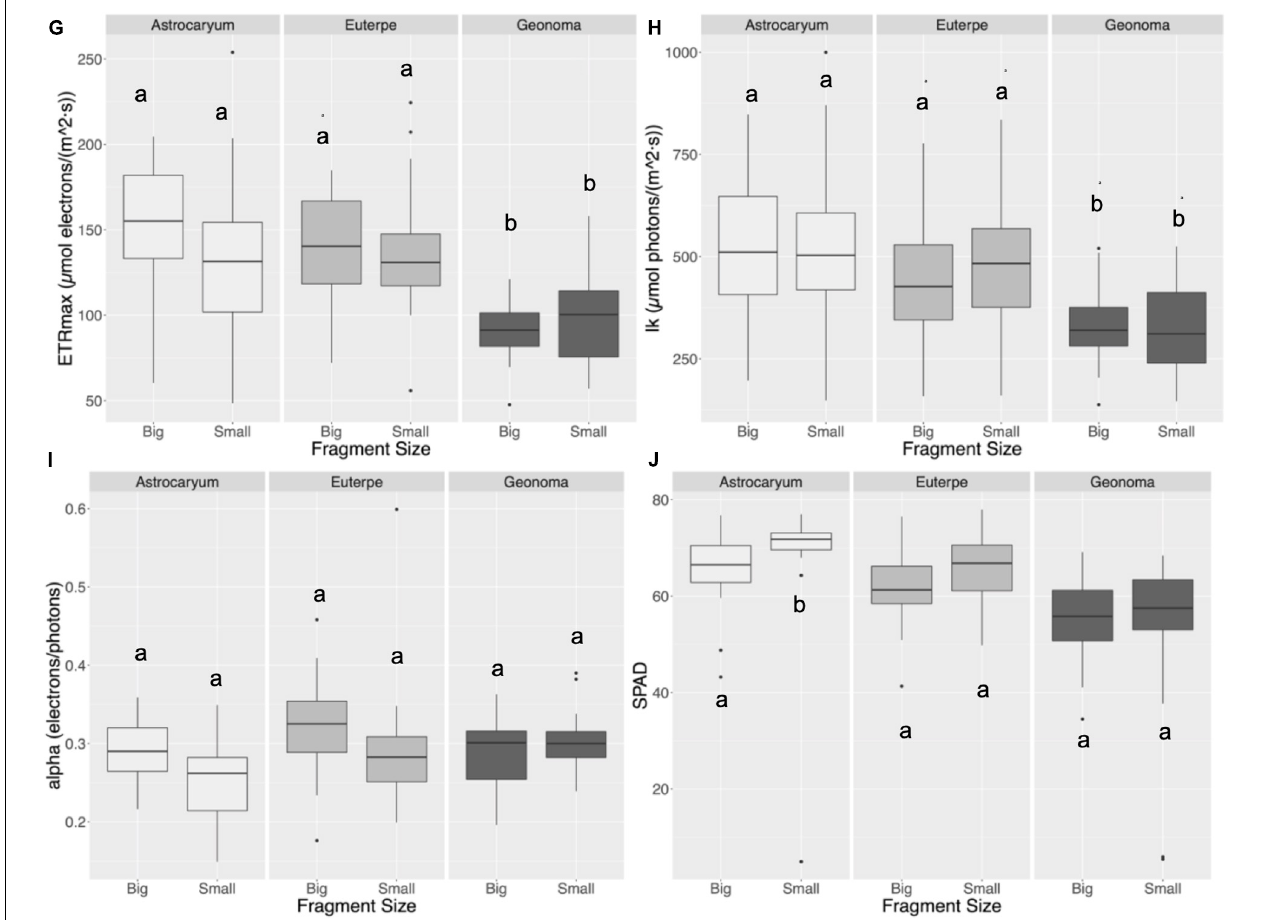
FIGURE 2 | Functional traits measured for each palm species in large and small fragments: height (H, cm – A ), basal stem diameter (BSD, mm – B ), leaf area (LA, cm 2 – C ), leaf thickness (TH, mm – D ), and leaf dry matter content (LDMC, mg · g − 1 – E ), specific leaf area (SLA, m 2 · kg − 1 – F ). We used rapid light curves (RLC) to measure the present state of photosynthesis using a PAM-2500 Portable Chlorophyll Fluorometer (Waltz). RLC provide the key parameter α (alpha, electrons/photons – I ), which represents the initial slope of RLC related to the quantum efficiency of photosynthesis, maximum electron transport rate [ETRmax, µ mol electrons/(m 2 · s) – G ], and I K , [ µ mol photons/(m 2 · s) – H ], which refers to the minimum saturating irradiance and chlorophyll concentration (SPAD – J ). The bootstrap confidence intervals were calculated for mean difference, lowercase letters indicate differences in the mean value of the attribute between species, and capital letters indicate differences between